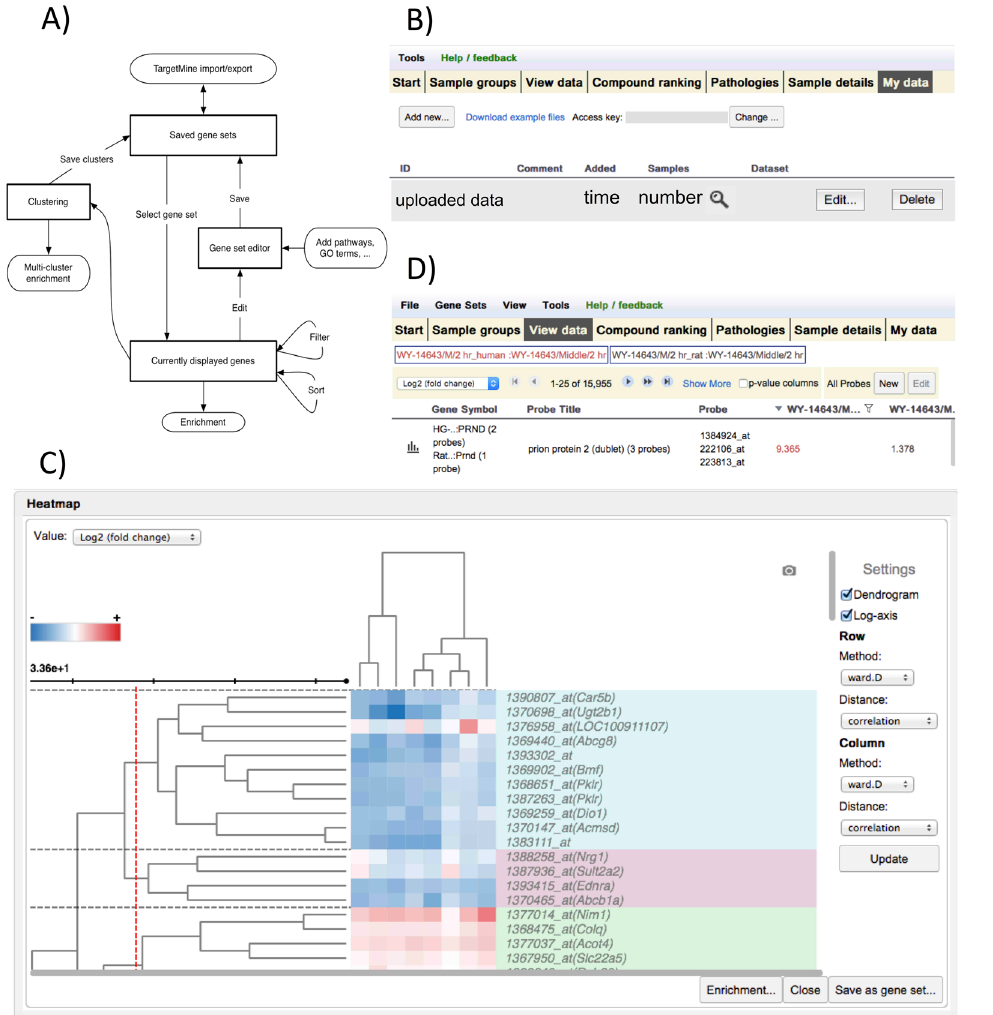
Figure 1. ( A ) Many functions in Toxygates now communicate with each other by modifying or transferring gene sets. Currently displayed genes can be filtered, sorted and tested for enrichment, and saved as a named set. They can also be clustered, and by setting a dendrogram cutoff, new gene sets can be generated, as well as enriched together. Gene sets are saved as local data in the web browser. They may be manually edited, for example by adding pathways and GO terms, and saved gene sets may be synchronised with TargetMine for further analysis and long term storage. ( B ) The My Data screen. Here, users can upload, adjust, and delete their own expression data as sets of samples (called batches ). ( C ) Interactive display of heatmap with dendrogram. After selecting compounds and experimental conditions and filtering genes of interest, a clustering may be performed and displayed as a heatmap in a new pop-up window by selecting “Show heatmap” from “Tools” pull-down menu at the top of the main display. The parameters of the clustering may be changed by using the controls on the right side of the display. ( D ) When the currently defined sample groups contain more than one platform (i.e. more than one species), the orthologous mode is activated. This uses pre-computed groups of probes (based on amino acid sequence similarity) to display orthologous genes together as a single row. This allows for meaningful cross-species analysis, which is especially useful since Open TG-GATEs contains both rat and human data. The high-resolution image file is available at Scientific Reports